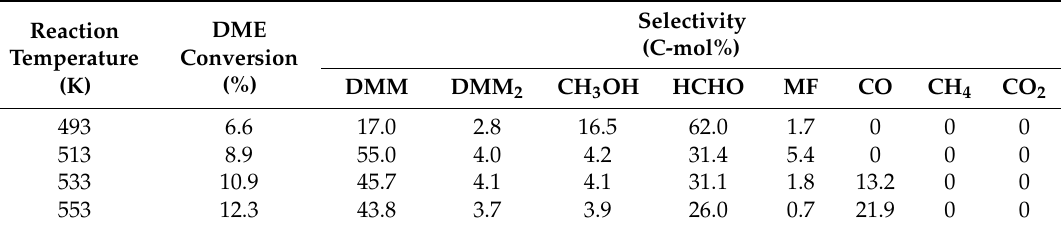
Table 2. Effects of reaction temperature on the performance of 5%Re-30%PW 12 /CNTs.